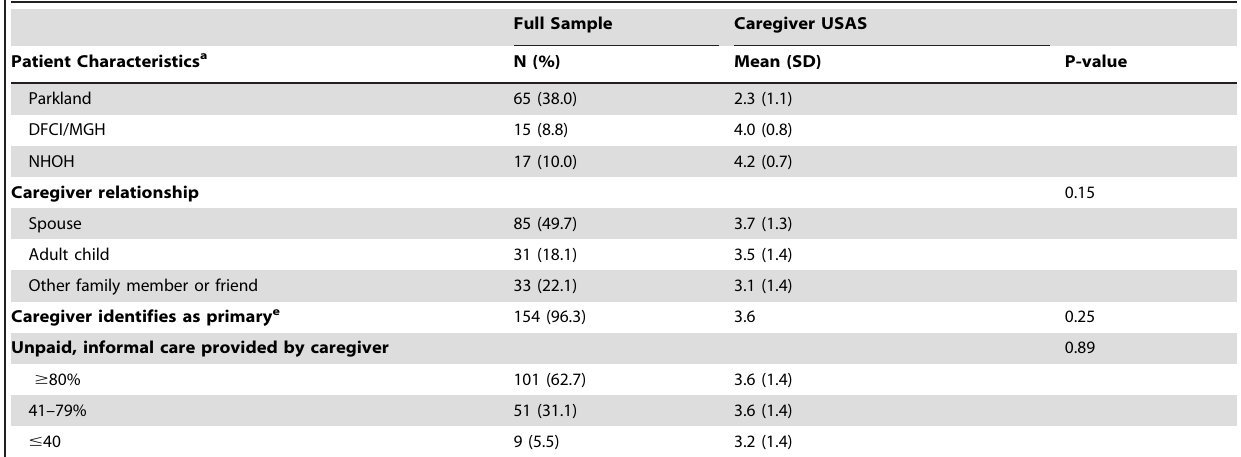
Full Sample Caregiver